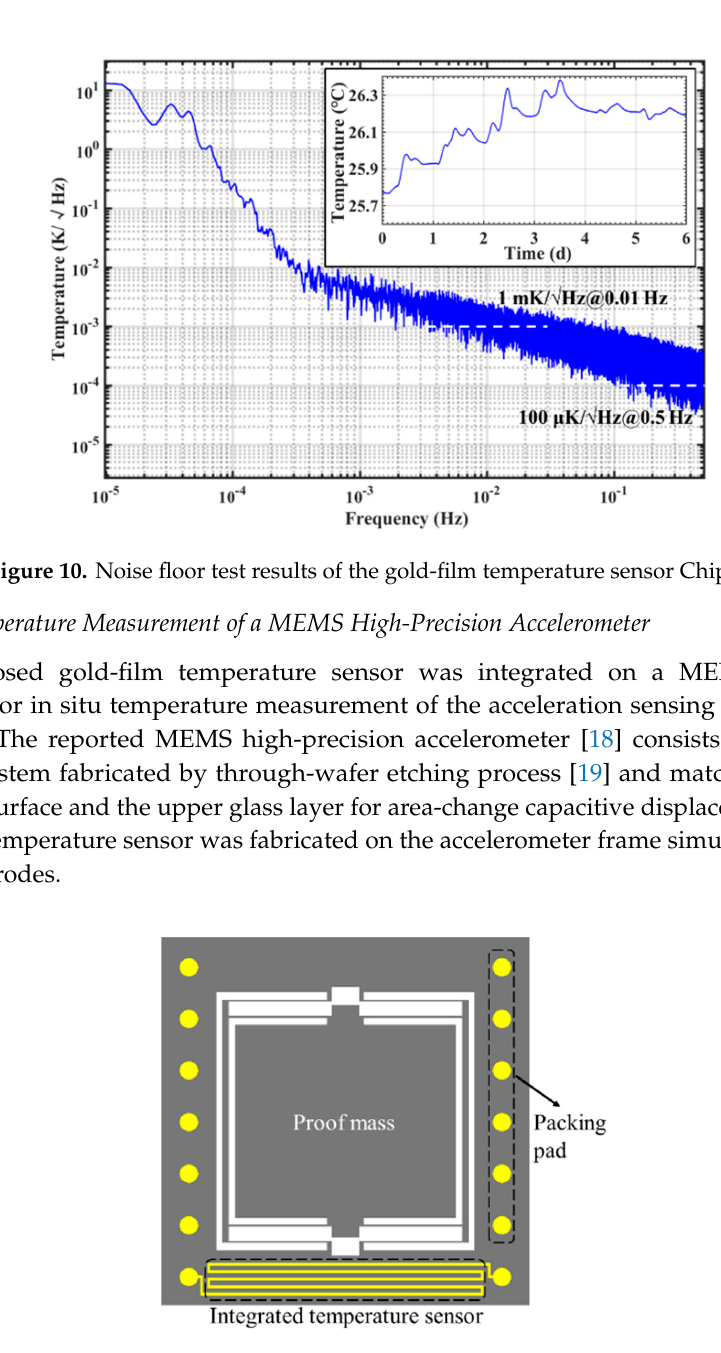
Figure 11. Microelectromechanical systems (MEMS) accelerometer with integrated gold-film temperature sensor.